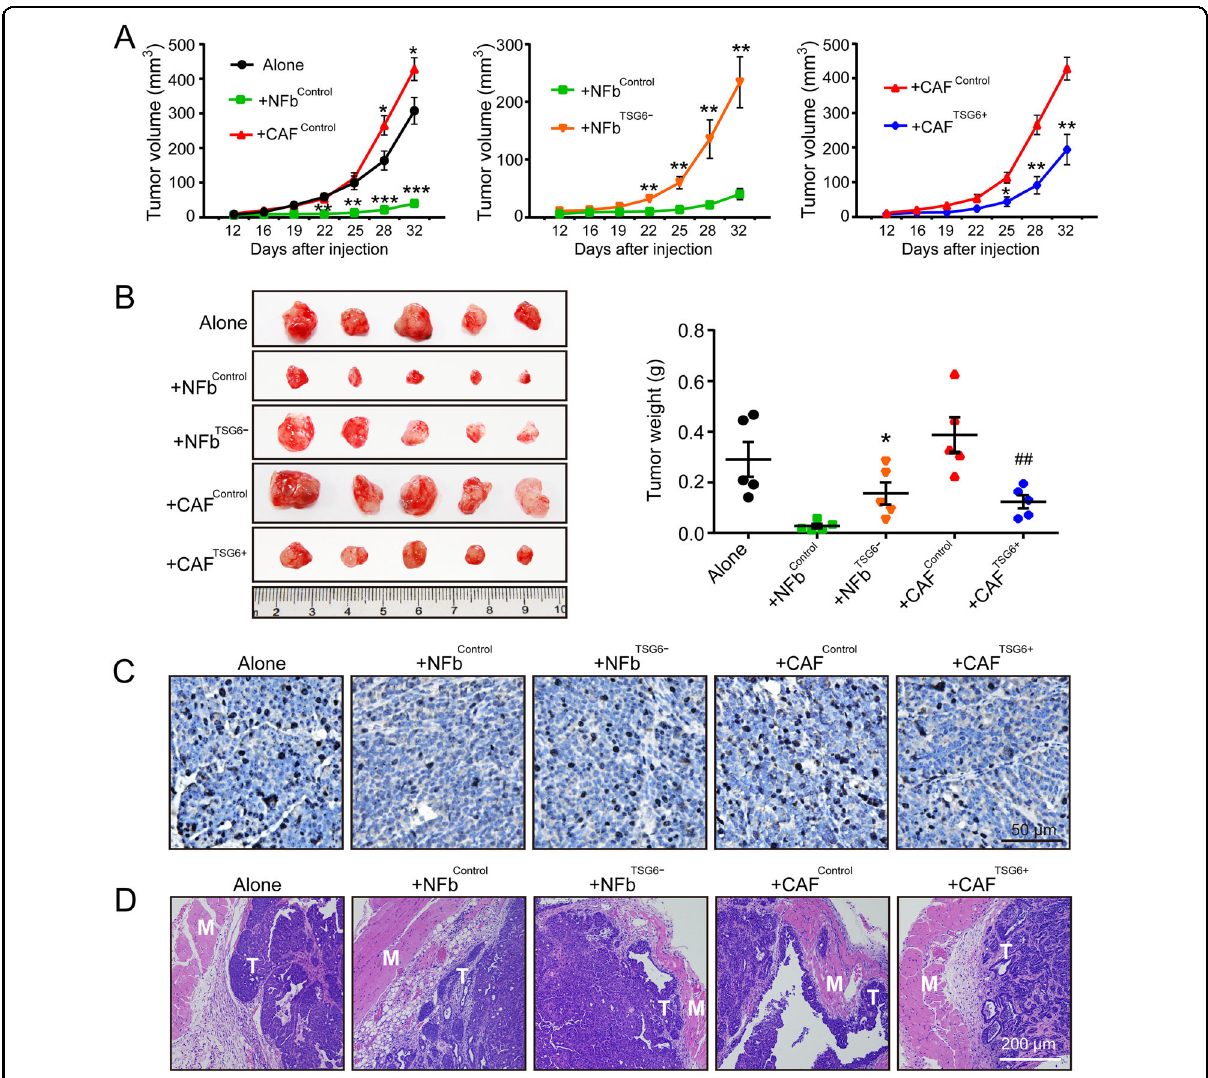
Fig. 6 The tumor growth and invasion of MMTV tumor cells in vivo. MMTV tumor cells alone or mixed with NFb Control , NFb TSG6 − , CAF Control , and CAF TSG6 + cells were injected into mammary fat pads of female nude mice ( n = 5 each group). A Graphs showing the change of tumor volume over time. Error bars represent mean ± SEM values. Statistically signi fi cant differences were determined using t test. * p < 0.05, ** p < 0.01, *** p < 0.001. B Tumor images and statistical graph of tumor weight. Error bars represent mean ± SEM values. Statistical analysis was performed using Mann – Whitney test. * p < 0.05 (vs + NFb Control ), ## p < 0.01 (vs + CAF Control ). C Ki67 expression in tumor tissues from different groups. Black nuclei indicate Ki67-positive ones. D H&E staining of muscle (M) and tumor (T)